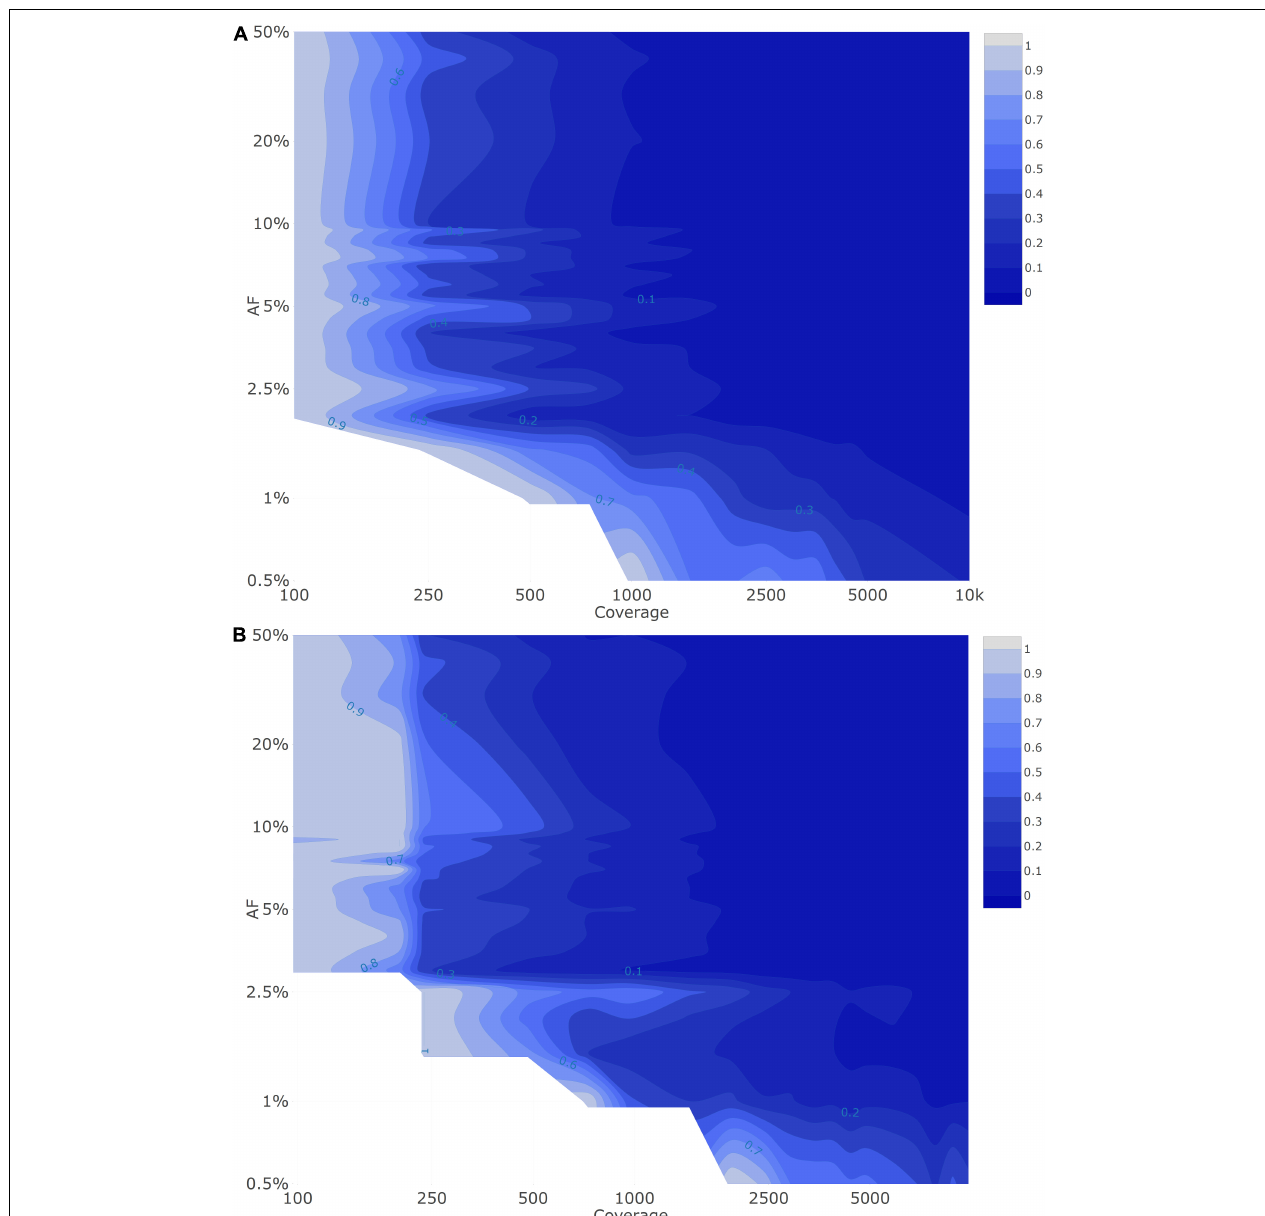
FIGURE 3 | Quantitative evaluation of Dataset 1 (A) and Dataset 2 (B) using the squared SD divided by the maximal squared SD per targeted AF. The figure is colored ranging from 0 (dark) to 1 (light) in intervals of 0.1 as extrapolated using a contour plot in the R package plotly (Sievert, 2020) (actual values are presented in Supplementary File 3 for Dataset 1 and Supplementary File 4 for Dataset 2). Both the X - and Y -axis follow a logarithmic scale. Conditions with a FN proportion higher than 75% were excluded and correspond to the white plane in the lower left